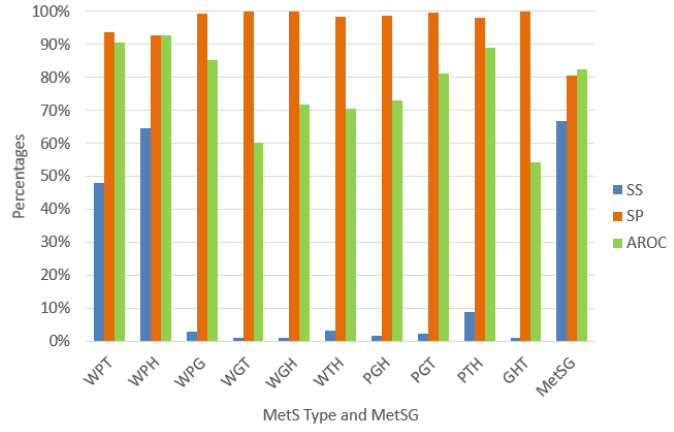
Figure 7. Performance indicators of the ANN for the MetS types using the original